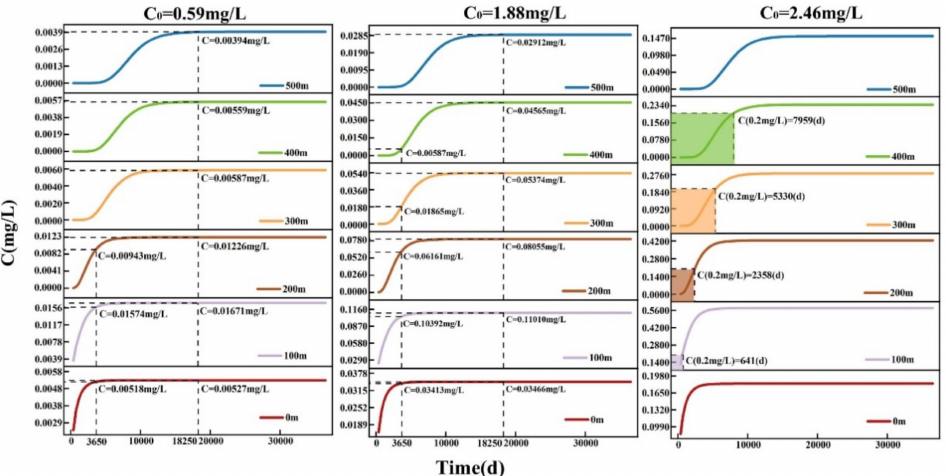
Figure 8. Changes in the spatiotemporal transport of TP in the western part of study area under different source